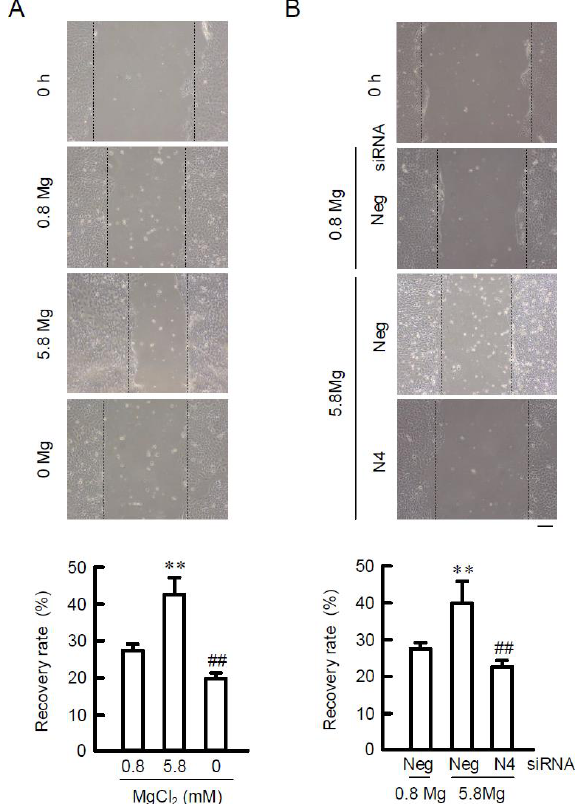
Figure 5. Effects of extracellular Mg 2+ concentration and NIPAL4 siRNA on cell migration. ( A ) After reaching confluent densities, the cells were incubated in 0, 0.8, and 5.8 mM MgCl 2 media for 24 h. Then, the cells were scratched with tip of a 200-μL pipette tip. The image of 0 h was taken at just after scratch. Other images were taken after 24 h. ( B ) Cells were transfected with negative (Neg) or NIPAL4 (N4) siRNA. After 66 h of transfection, the cells were incubated in 0.8 and 5.8 mM MgCl 2 media for 24 h. Then, the cells were scratched with tip of a 200-μL pipette tip. The images were taken after 24 h. The recovery rate is presented as the percentage of scratch closure. Scale bar indicates 50 μm. n = 4–6. ** p < 0.01 significantly different from 0.8 mM MgCl 2 . ## p < 0.01 significantly different from 5.8 mM MgCl 2 or negative siRNA plus 5.8 mM MgCl 2 .